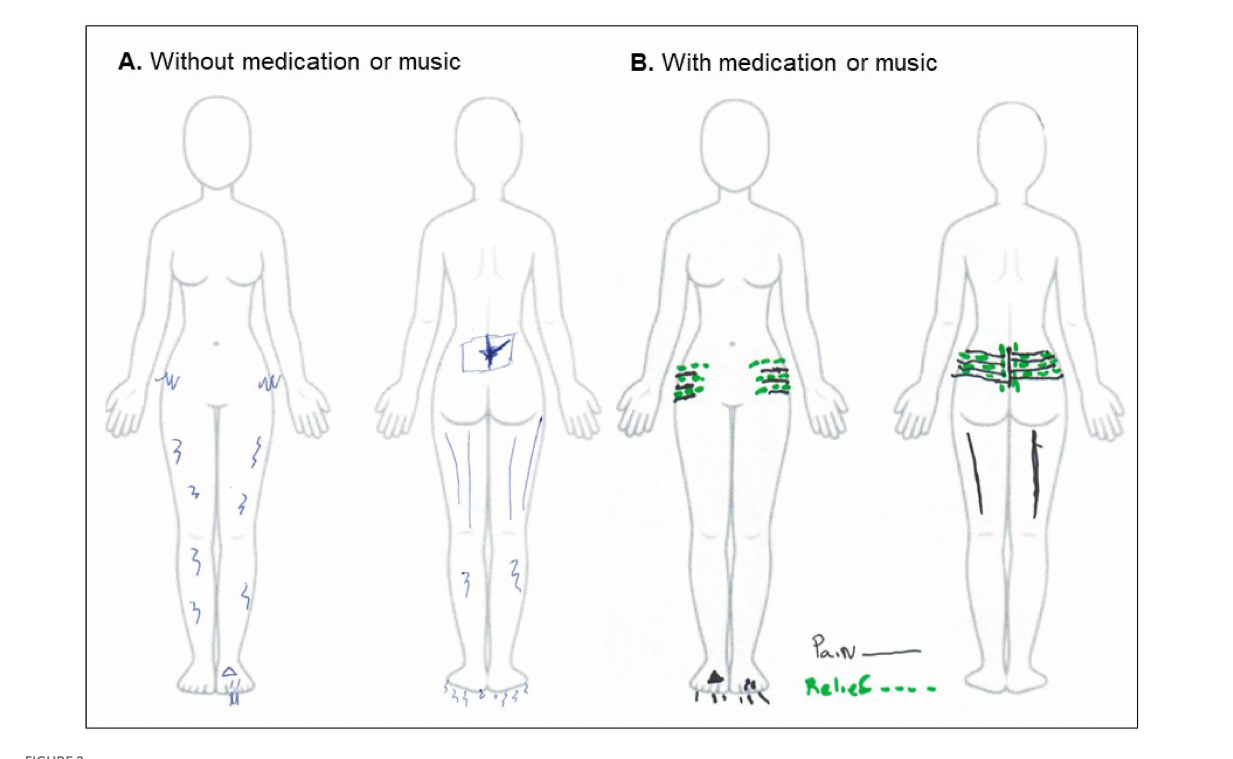
FIGURE 2 Location of pain when she has not used medication (A) and when she took medication or listened to music (B) . When there were no periods of medication, the pain was felt in the back of the legs, which was sciatica, and nerve pain in the legs and under the feet. When she took medication or listened to music, she felt pain in her lower spine and feet, where she also felt